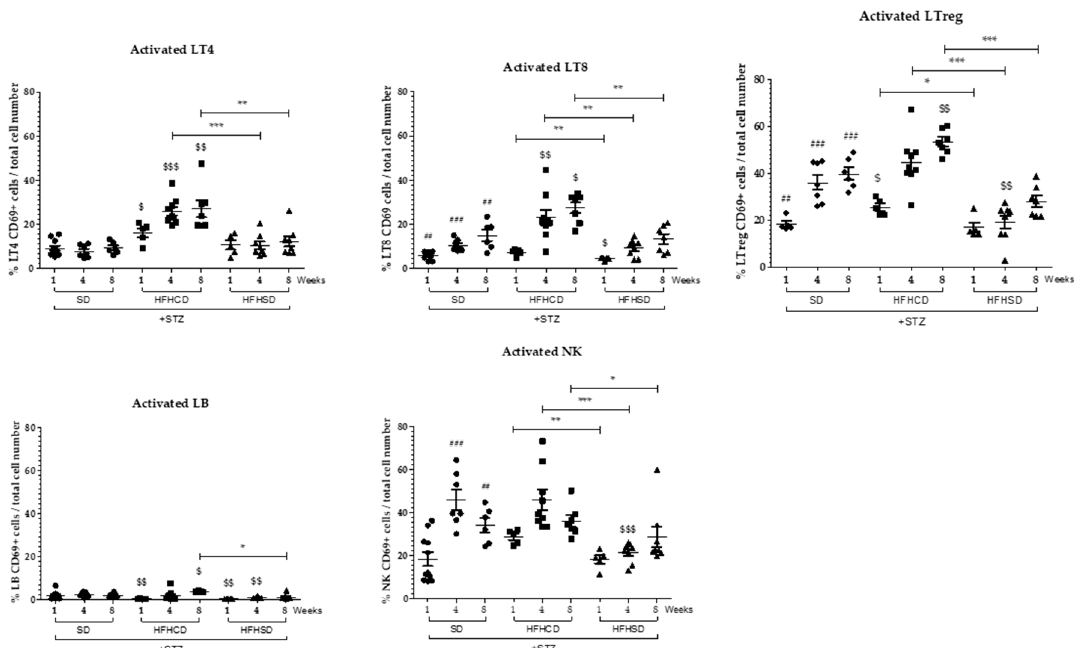
Figure 6. Analysis of the activation of hepatic immune infiltrates during HCC development on NASH background. Diabetic (STZ) C57Bl6/J male mice were fed either a SD, a HFHCD or a HFHSD during 1, 4 and 8 weeks. Percentages of activated CD4+ T cells (Activated LT4), CD8+ T cells (Activated LT8), regulatory T cells (Activated LTreg), B cells (Activated LB) and Natural Killer (Activated NK) cells. For all graph, each black dots, black squares and black triangles represent individuals from the different groups: diabetic mice under SD, diabetic mice under HFHCD or HFHSD, respectively. # p < 0.05; ## p < 0.01 and ### p < 0.001 compared diabetic mice under SD to healthy mice under SD; $ p < 0.05; $$ p < 0.01 and $$$ p < 0.001 compared diabetic mice under HFHCD or HFHSD to diabetic mice under SD; * p < 0.05; ** p < 0.01 and *** p < 0.001 compared diabetic mice under HFHCD to diabetic mice under HFHSD at same time point.